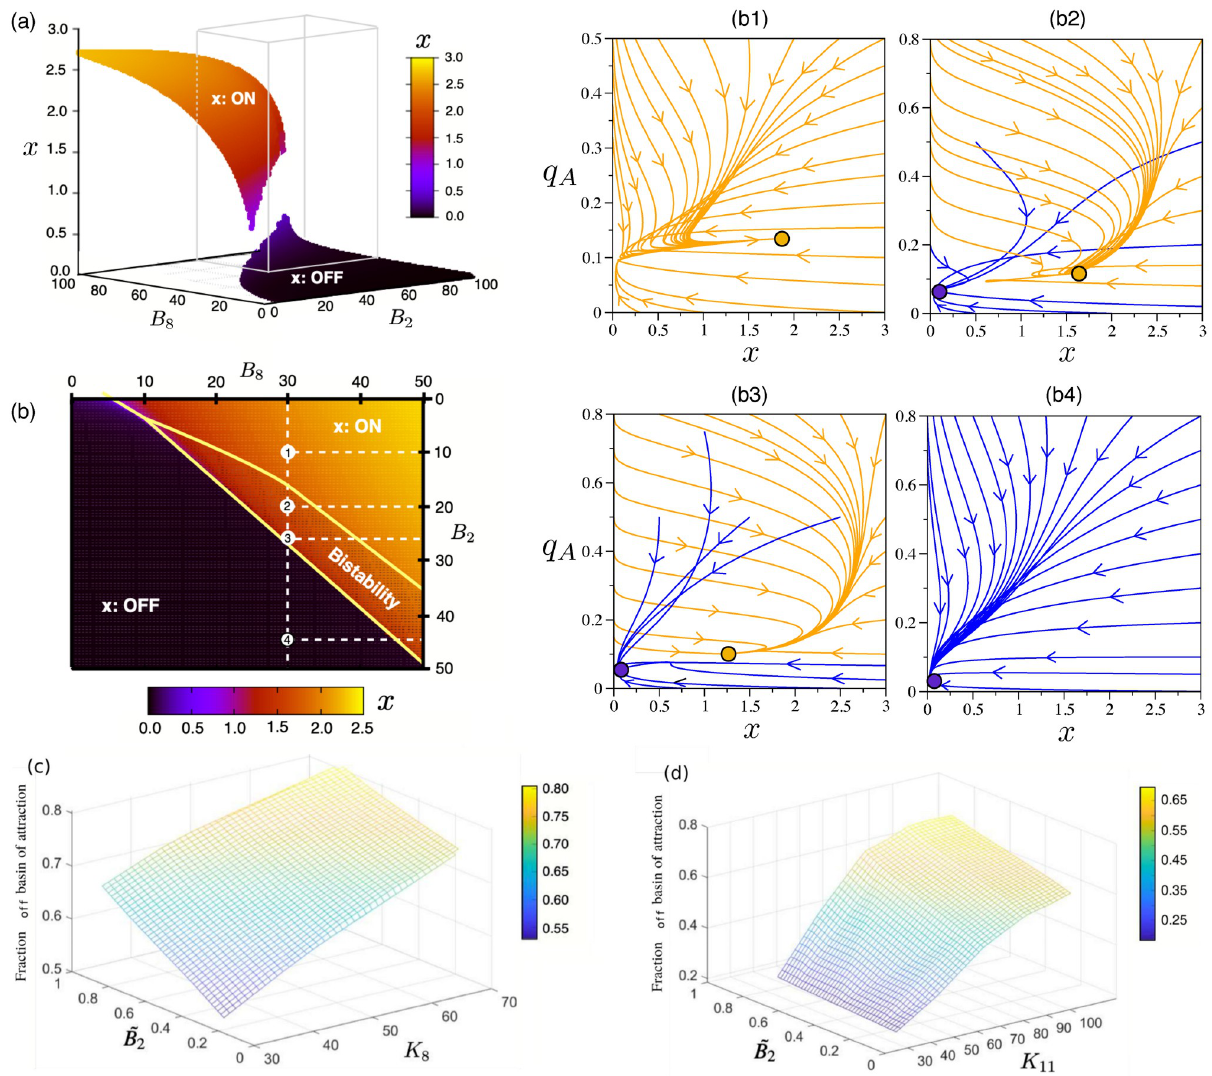
Fig 5. Equilibria in the parameter space ( B 2, B 8). Panel (a) shows the equilibrium concentration of the TF (variable x ) in the parameter space ( B 2, B 8), the upper (resp., lower) sheet corresponding to the high (resp., low) level of expression, labelled as ON (resp., OFF) state. Panel (b) displays an enlarged view within the range contained in the cube in (a), namely 0 � B 2 , B 8 � 50. The region contained in the central orangish area corresponds to bistability. (b1-b4) Phase portraits showing the dynamics in the parameter space ( x , q ) for the combination of parameters B 2 , B 8 indicated with dashed lines in (b), A computed using � = 0.1. The orange and blue orbits correspond to the dynamics achieving the ON and OFF states, respectively. Note that both (b2) and (b3) fall into the region of bistability. Panels (c) and (d) show the relative size of the basin of attraction of the OFF equilibrium for parameter sets within (cid:0) ~ B , where K 11 is set to be 94.155549; (d) Parameter plane K (cid:0) ~ B , where B 8 is set to be 30. For the sake the bistability region: (c) Parameter plane B 8 2 11 2 of visualisation, ~ B stands for a normalization of parameter B 2 , see (S.34) in Section S.1.3 in the S1 Text Other constants are fixed according to the 2 parameter set 2 (see Table I in S1